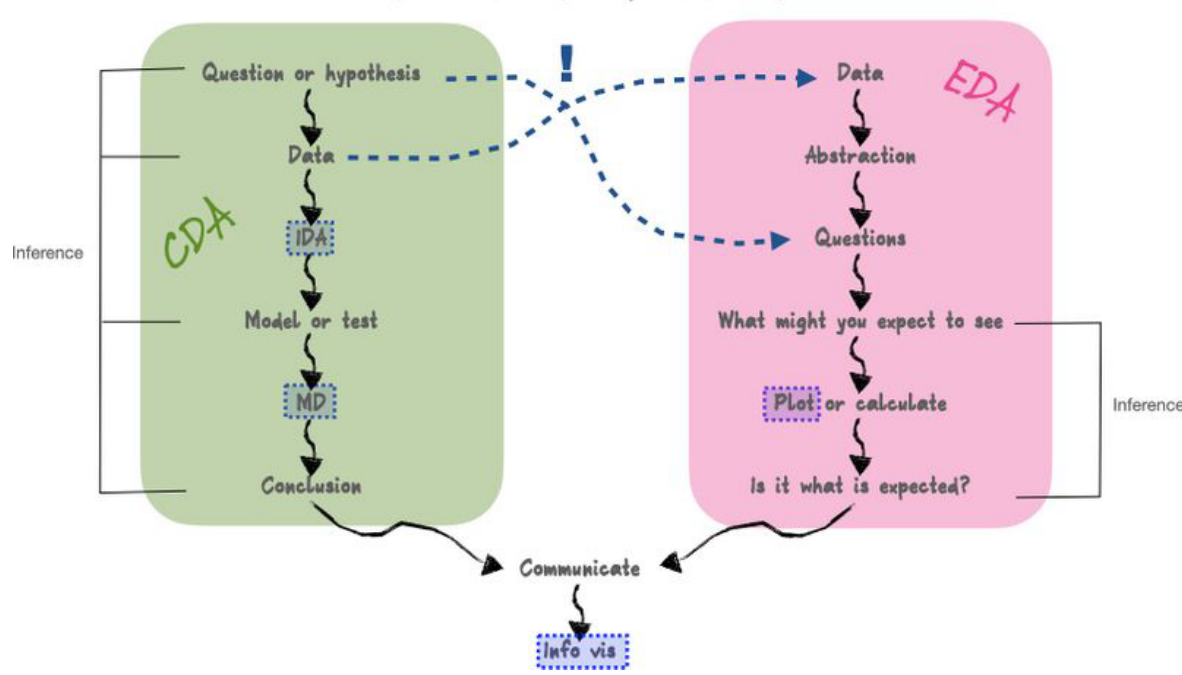
Figure 1. An illustration of the distinction between exploratory data analysis (EDA) and confirmatory data analysis (CDA), and the related areas of initial data analysis (IDA), model diagnostics (MD) and information visualization (info vis). The dashed boxes indicate areas where data graphics are common practice. Inference enters these analysis pipelines in different places. Importantly, the starting points for EDA and CDA are